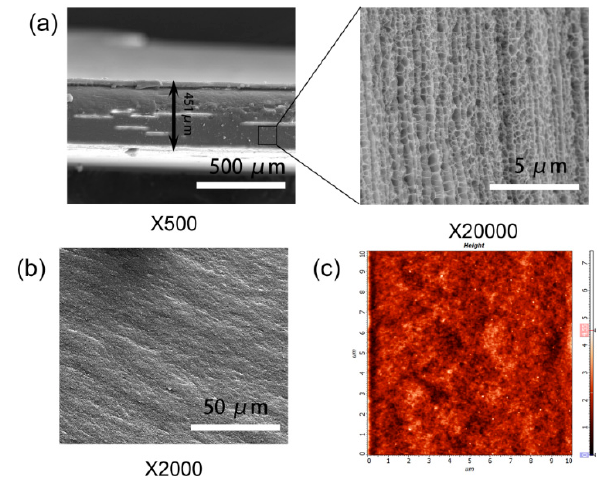
Figure 8. ( a ) Typical SEM images of cross-section of PAS gel coating with different magnifications; ( b ) SEM image of the surface of PAS gel coating; ( c ) atomic force microscopy (AFM) image of the surface of PAS gel coating.